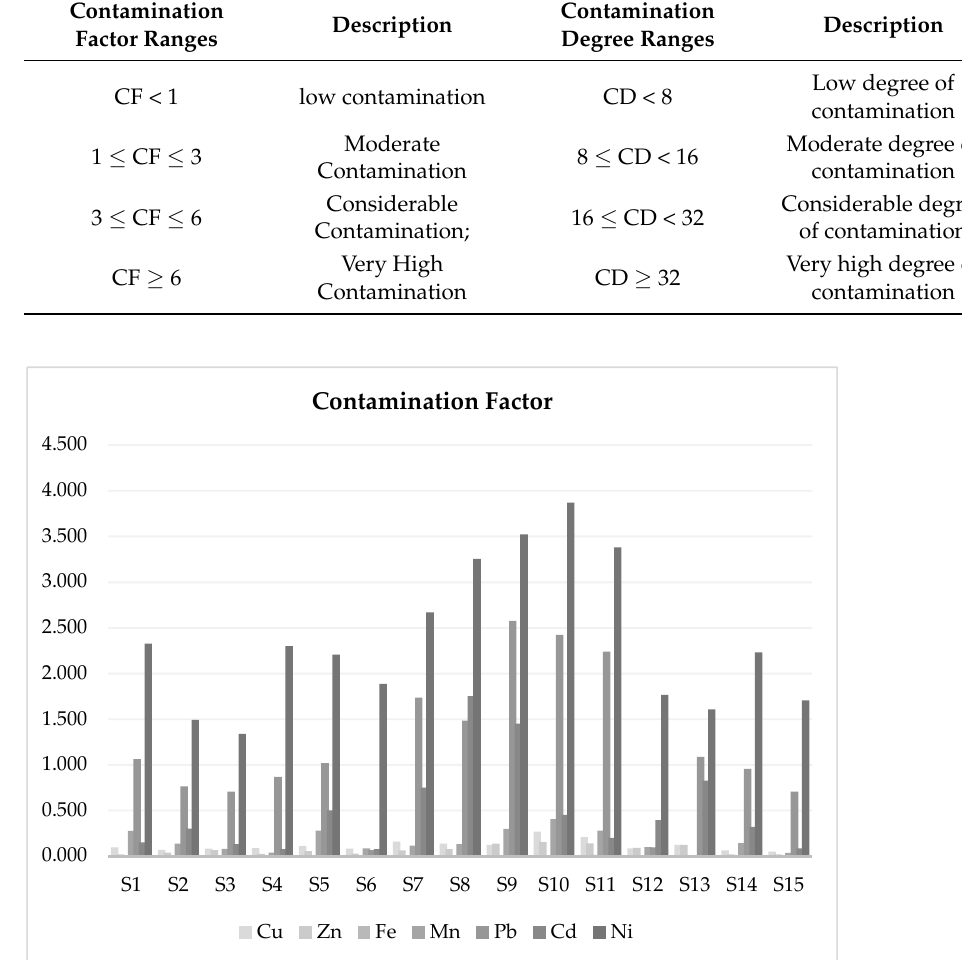
Figure 2. Contamination Factor of heavy metals at all sample stations .